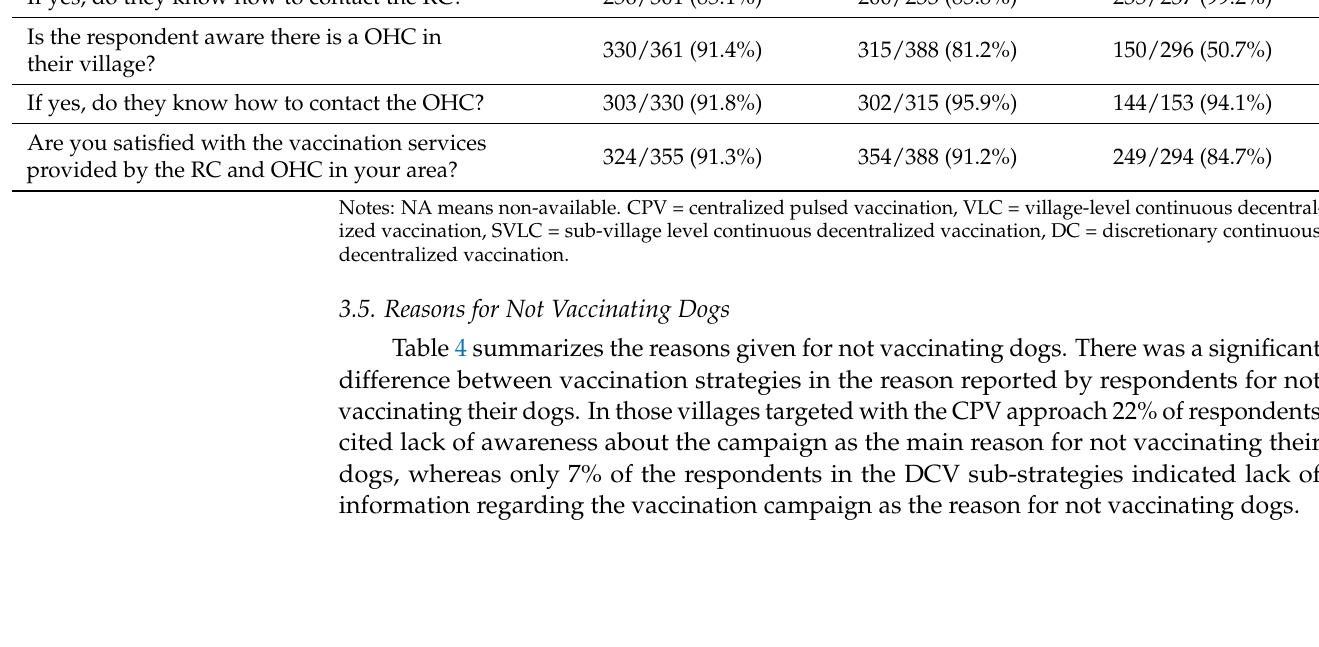
Table 4. Reasons for not vaccinating dogs under centralized pulsed vaccination and decentralized continuous vaccination strategies.